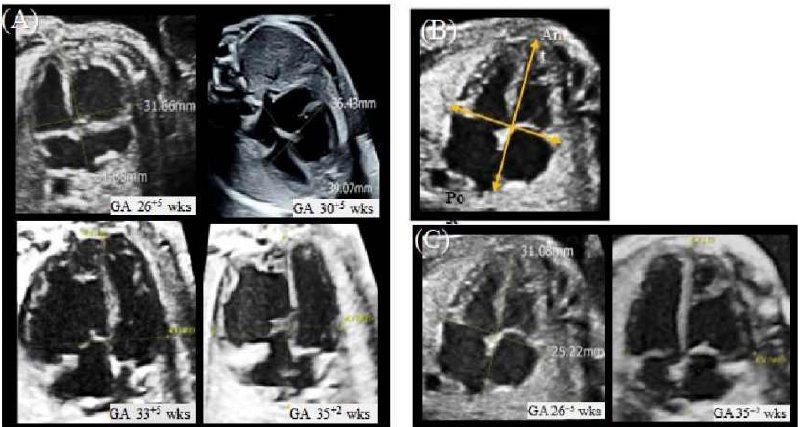
Figure 3. Measurement of the GSI . ( A ) The measurement of the GSI in the fetus with CVD at each gestational age. The first two scans (GA26 +5 weeks, GA 30 +5 weeks) were performed with B-mode imaging. The latter two scans (GA33 +5 weeks, GA35 +5 weeks) were performed with STIC imaging with Fetal HQ. ( B ) The measurement of the GSI in the first two scans (GA26 +5 weeks, GA 30 +5 weeks). In the 4CV, the basal-apical length (BAL) was measured at end-ventricular diastole from the epicardial border of the posterior atrial wall to the epicardial border of the apical ventricular wall. Transverse length (TL) at the widest part in the 4CV from the epicardial borders of the ventricular walls. The GSI was calculated formally with BAL/TL, and it was compared with the z score referenced in DeVore 2017. ( C ) The measurement of the GSI in the healthy fetus at each gestational age. The first scan (GA26 +5 weeks) was performed with B-mode imaging. The latter scan (GA33 +5 weeks, GA35 +5 weeks) was performed with STIC imaging with Fetal HQ. EFW, estimated fetal weight; GA, gestational age; GSI, global sphericity index; wks,